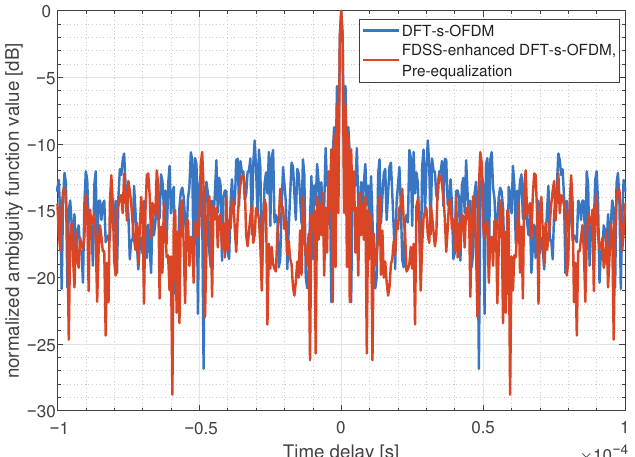
Figure 13. Comparison of ambiguity functions between DFT-s-OFDM and FDSS-enhanced DFT-s- OFDM with pre-equalization.